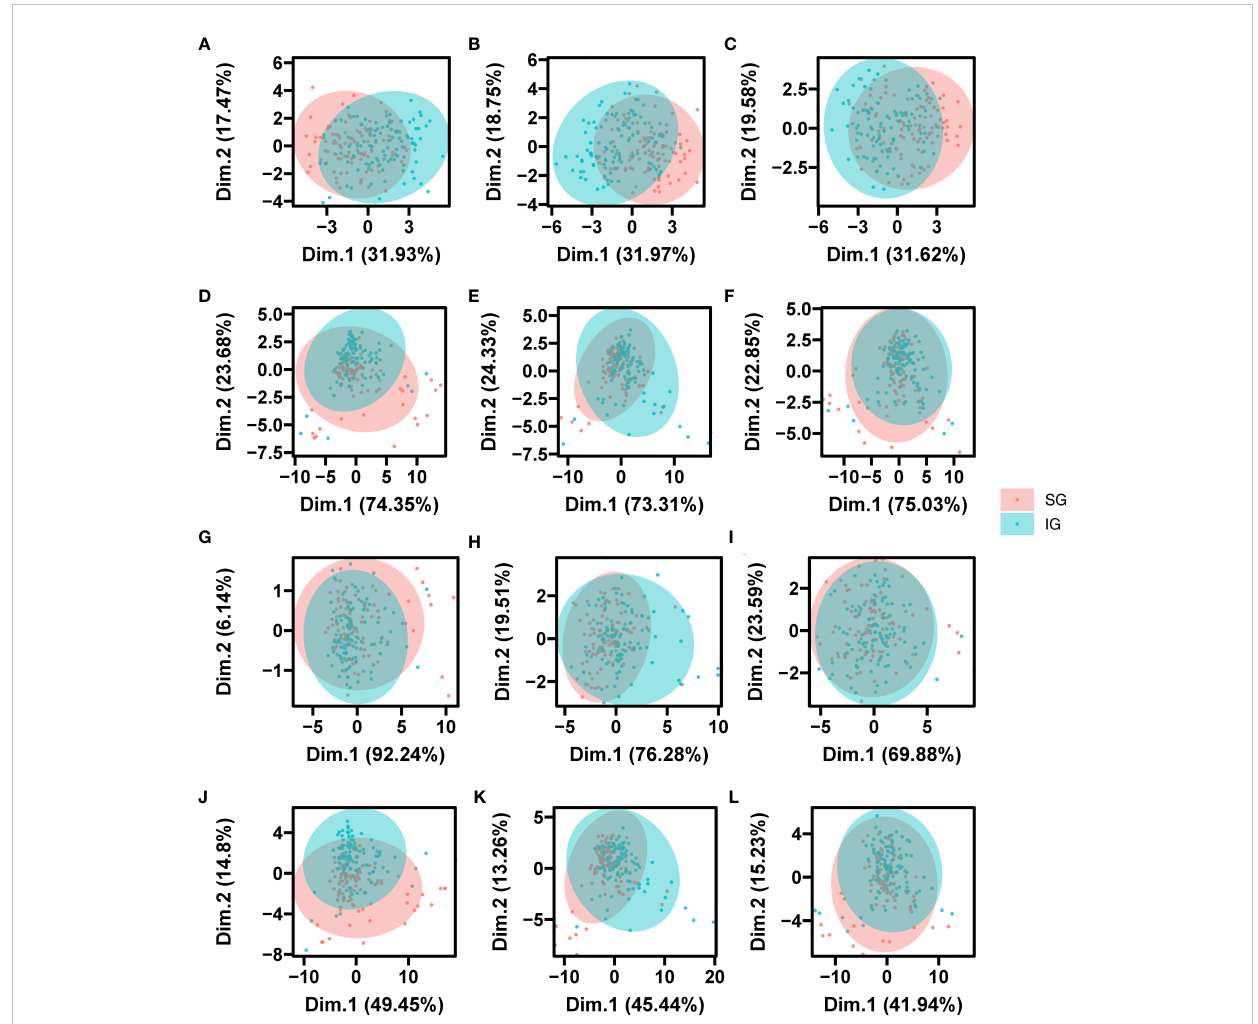
FIGURE 6 PCA score plot of grain position of seed based on the morphological data, the auto fl uorescence data, the multispectral data and multi-source fusion data. Figure (A – C) was morphological data, Figures (D – F) was auto fl uorescence data, (G – I) was multispectral data, and (J – L) was multi-source fusion data. Figures (A, D, G, J) were MRS; Figures (B, E, H, K) were DS; Figures (C, F, I, L) were